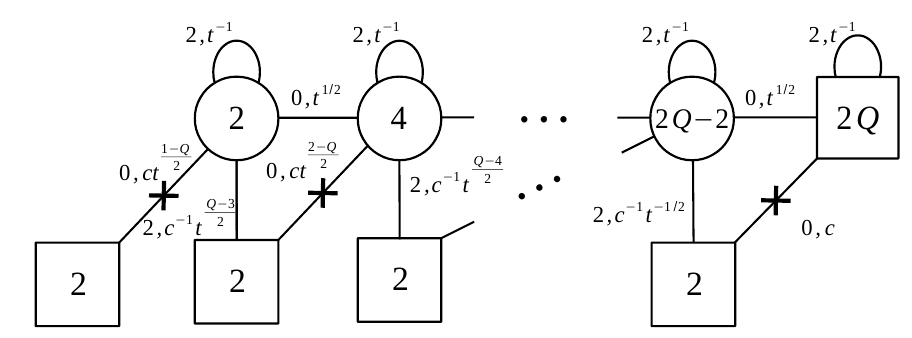
× U ( 1 ) . The q and q charges c t c t